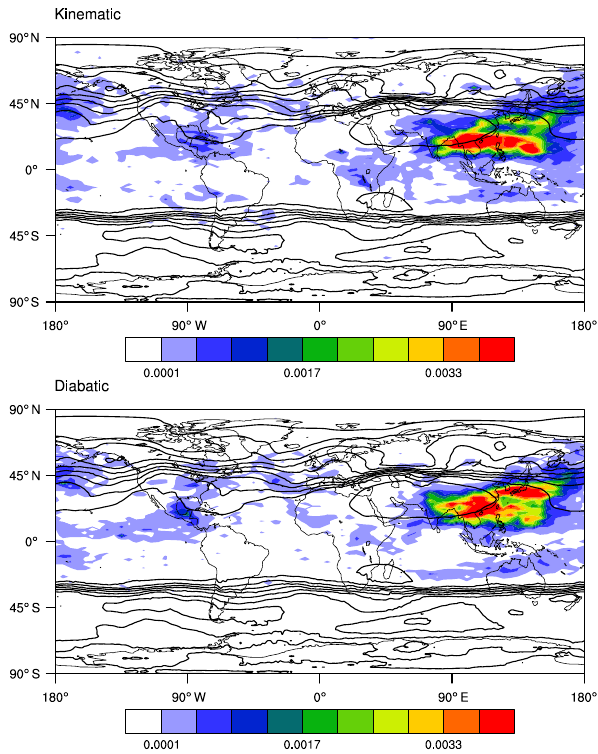
Figure 11. Geographical distribution of locations of tropopause crossings (as fraction of all trajectories; top panel: kinematic; bot- tom panel: diabatic) and contours of thermal tropopause height (black; contours between 110 and 290hPa with interval 20hPa). In order to exclude short-term reversible events, results here only include parcels remaining in the troposphere 5 days before and in the stratosphere 5 days after crossing the tropopause.